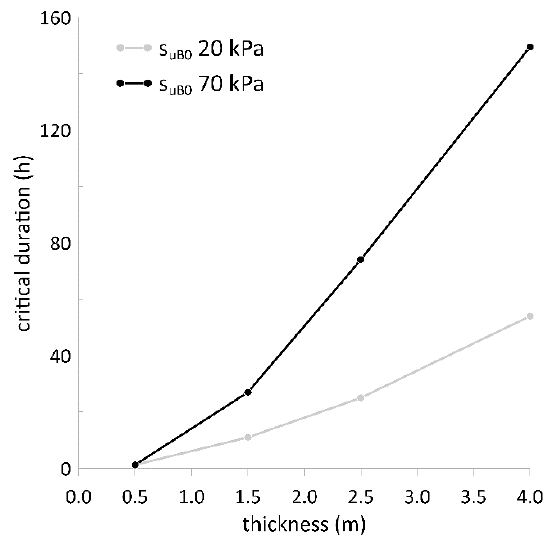
Figure 13. Results of set D analyses: backdated critical duration against domain thickness for two different initial suction values.